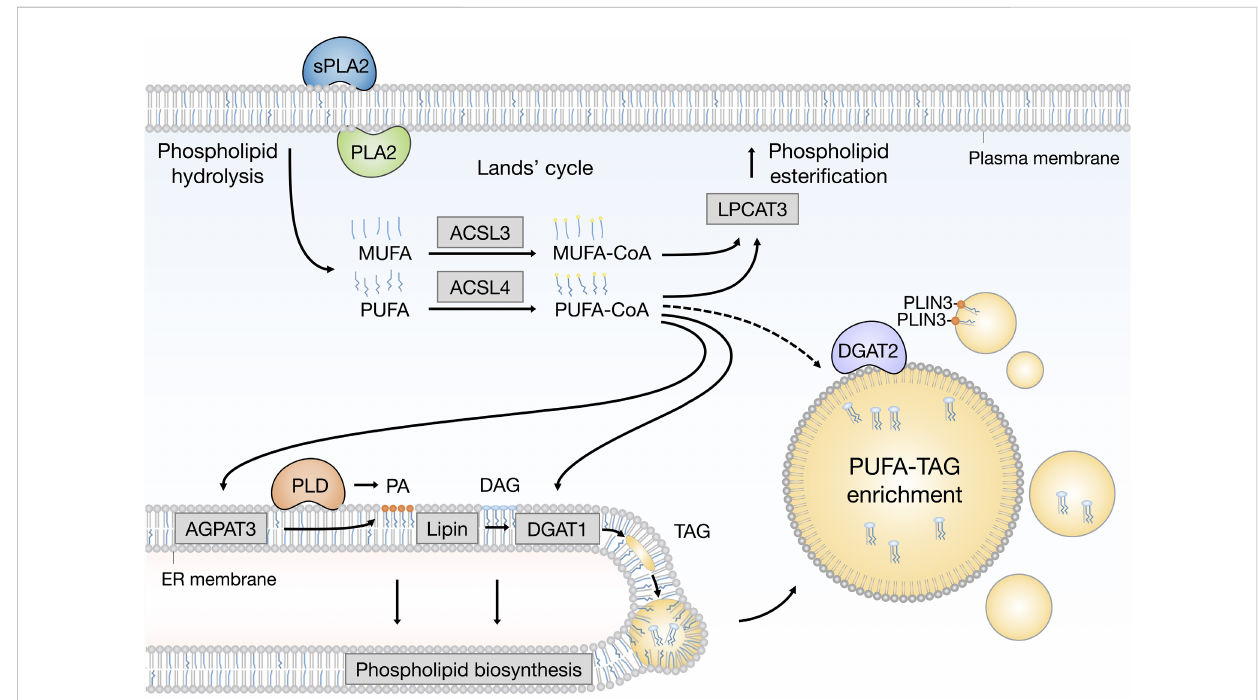
FIGURE 2 Emerging pathways of PUFA channeling from membranes to lipid droplets (LDs). The redistribution of PUFAs into TAGs stored within LDs can occur via at least two conceptually distinct lipid remodeling pathways driven by PLA2 and PLD enzymes. PLA2-catalysed phospholipid hydrolysis liberates membraneresidentPUFAs,whicharereleasedintothecytosol.Tore-enteranymetabolicorremodelingpathways,includingtheKennedypathwayofde novophospholipidandTAGbiosynthesis,PUFAshavetobe fi rstconvertedintoactivePUFA-CoAintermediatesbyCoAsynthetaseenzymes,suchas ACSL4, which shows preference for PUFAs, whereas the activation of MUFAs is preferentially handled by ACSL3. On the other hand, PLD-catalyzed hydrolysisofPUFA-richphospholipidsgeneratesPUFA-containingPA,whichremainscon fi nedtothe2Dspaceofthemembranebilayer.Thisinprinciple enablesamoreef fi cientchannelingofthePUFAacylchainintoTAGs via theKennedypathwaybythesequentialactionoflipinandDGAT1enzymeswithin the ER membrane. PUFA-PA can also be formed de novo via the AGPAT3 enzyme with known preference for PUFAs. In principle, with the help of LD- associated ACSL4, free PUFAs can also be converted into PUFA-TAGs by the DGAT2 enzyme, which can relocate from the ER to LDs to catalyze local LD expansion. In addition, PA formed by PLD can participate in lipid droplet formation and expansion by PLIN3 recruitment. Cofactors and by-products are omitted. ACSL3, acyl-CoA synthetase long chain family member 3; ACSL4, acyl-CoA synthetase long chain family member 4; AGPAT3 (also known as LPAAT3), 1-acyl-sn-glycerol-3- phosphate acyltransferase gamma; CoA, coenzyme A; DAG, diacylglycerol; DGAT1, diacylglycerol acyltransferase 1; ER, endoplasmic reticulum; LPCAT3, lysophosphatidylcholine acyltransferase 3; MUFA, monounsaturated fatty acid; PA, phosphatidic acid; PC, phosphatidylcholine; PE, phosphatidylethanolamine; PLA2, phospholipase A2; PLD, phospholipase D; PLIN3, perilipin 3; PS, phosphatidylserine; PUFA, polyunsaturated fatty acid; sPLA2, secreted phospholipase A2; TAG,